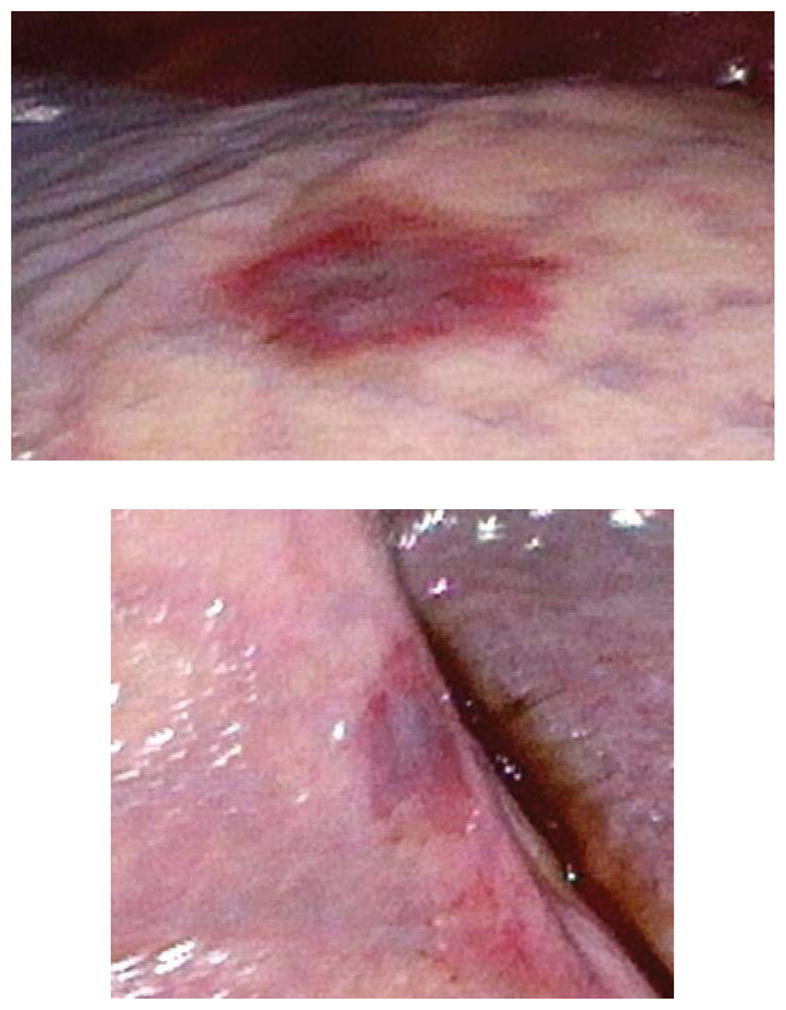
Pleural KS lesions.